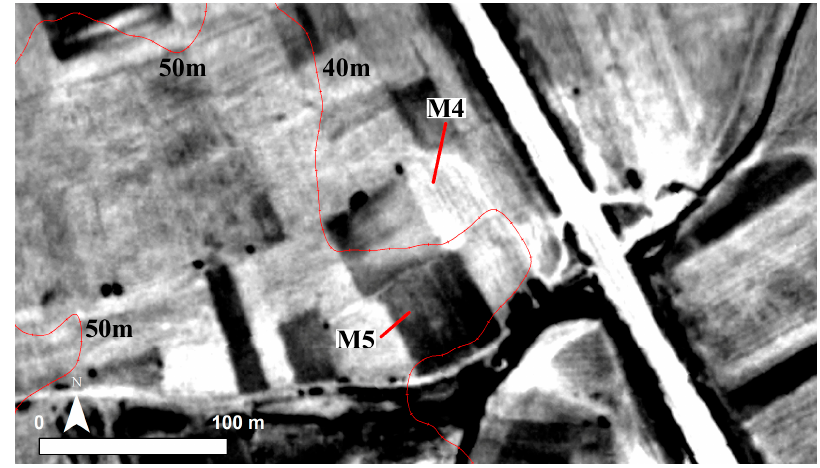
Figure 6. The 1971 historic aerial imagery from Kamara with modern elevation contours. The data predate modern intrusions to the site revealing two distinct soil marks.